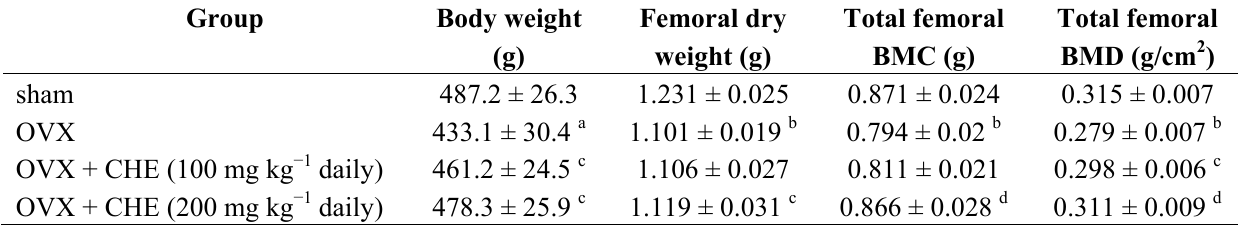
Table 1. Body weight, femoral dry weight, femoral mineral content, and density of experimental animals.